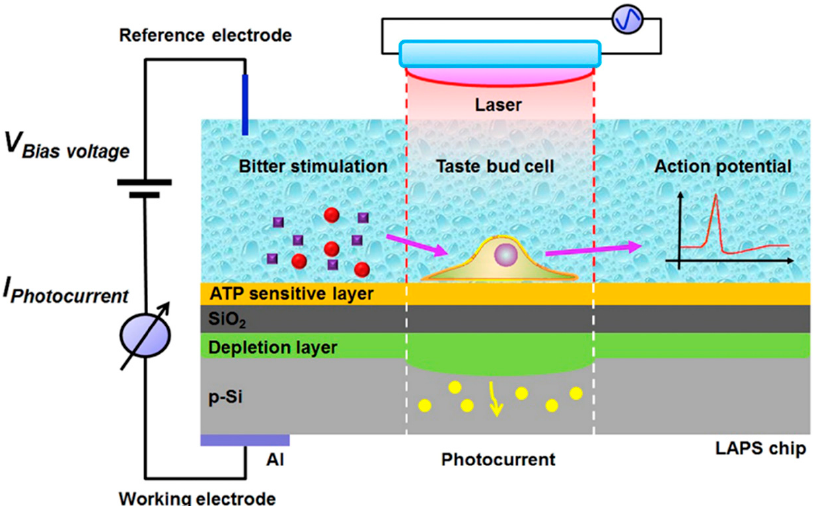
Figure 5. Schematic of the bitterness-sensing mechanism of the dual-functional bitter taste biosensor modi fi ed with taste bud cells and ATP-sensitive DNA aptamer on a semiconductor LAPS chip. Reproduced from [126] with permission from Elsevier.